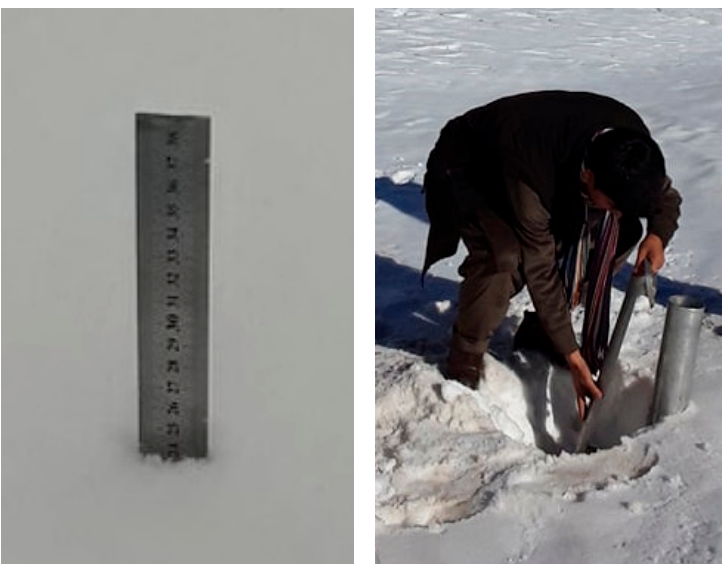
Figure 2. Field photographs from the campaigns conducted by a survey team from General Affairs of Snow and Glacier Analysis, Department of Surface Water, General Directorate of Water Resources, National Water Affairs Regulation Authority (GMSGA), Afghanistan. The left image shows the ruler used for the measurement of the snow depth. Additional measurements were obtained from snow tubes, as shown in the right image.